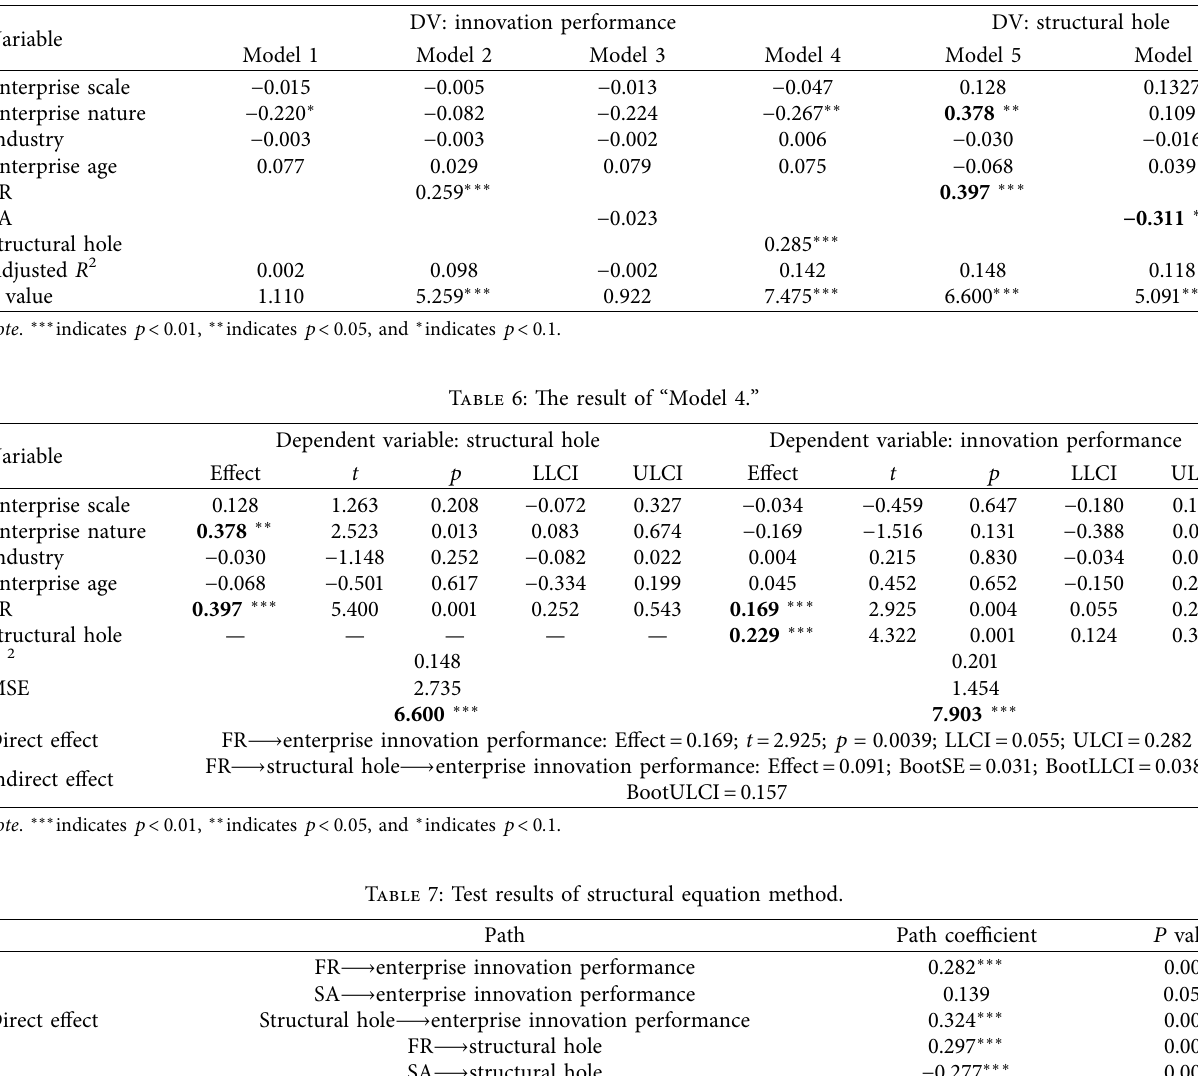
Table 5: Regression results